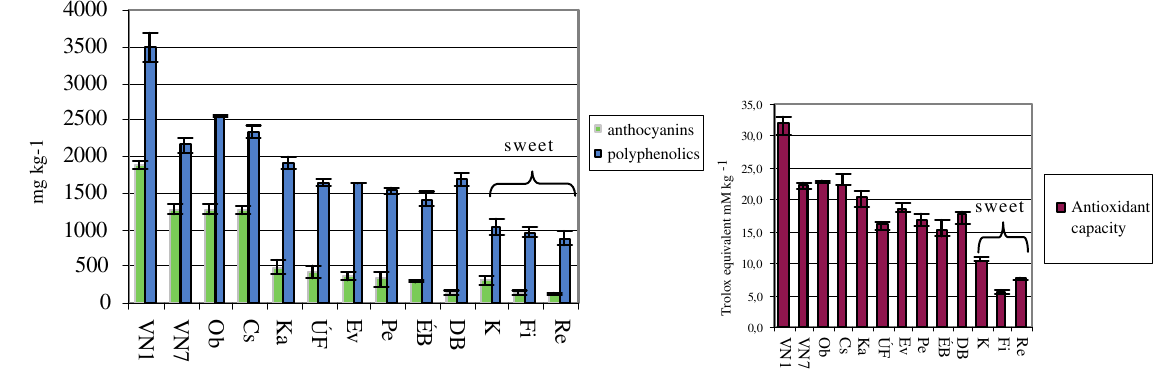
Figure1.A: anthocyanin, total polyphenol content B: antioxidant capacity of sweet and sour cherry cultivars. anthocyanin, total polyphenol, antioxidant